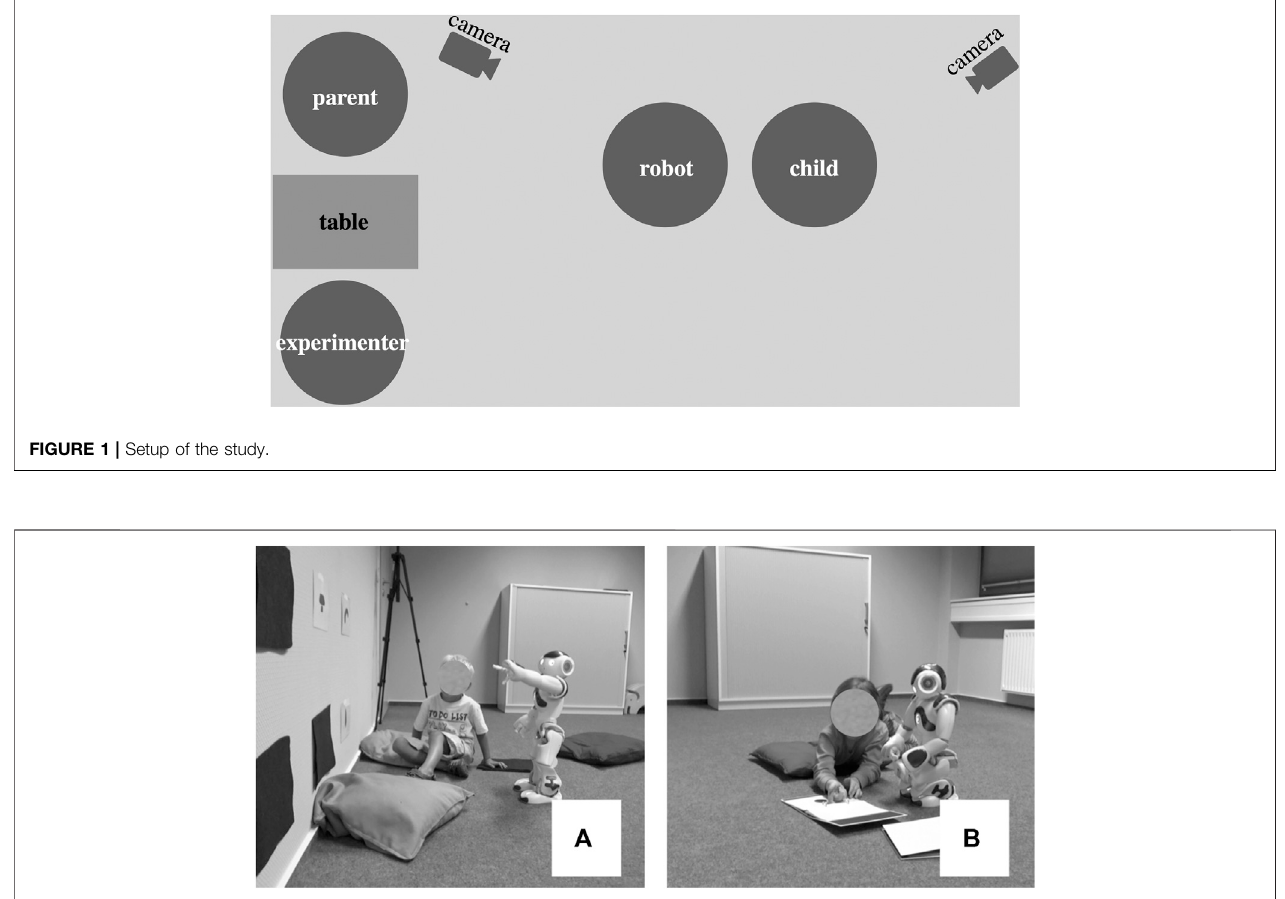
FIGURE 2 | The learning situation (A) and test situation (B)